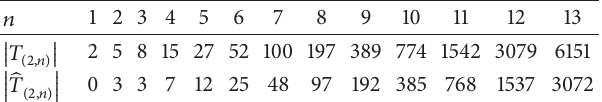
Table 1: Punctured polynomials over F 2